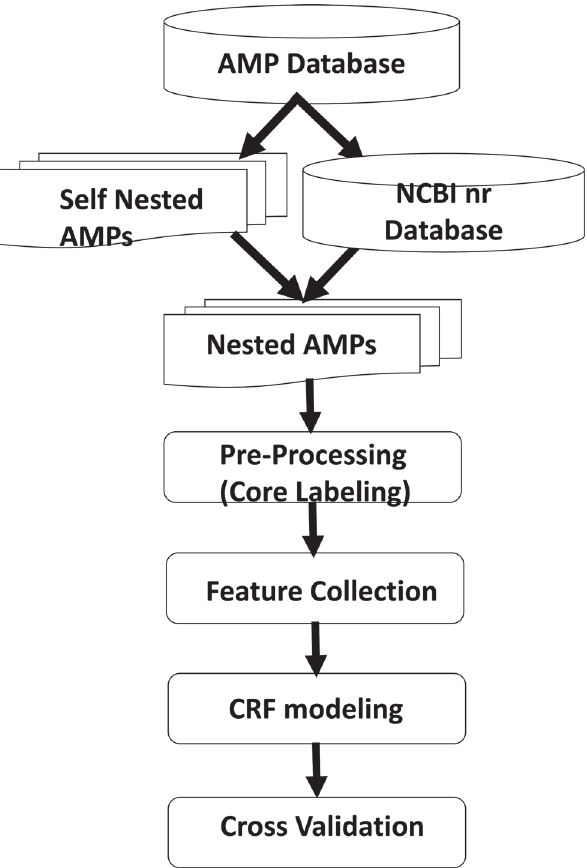
Fig 1. Flowchart of AMPcore. 2,497 non-redundant experimentally validated AMPs were obtained from CAMP release 2. 798 AMP nested families are recognized through self-comparison and their source proteins from NCBI nr database. The critical regions or cores of the nested families are then determined along with their features such as protein secondary structures and conserved domains. AMPcore are built using CRFs based on the nested AMPs and the performances are examined using 10-fold